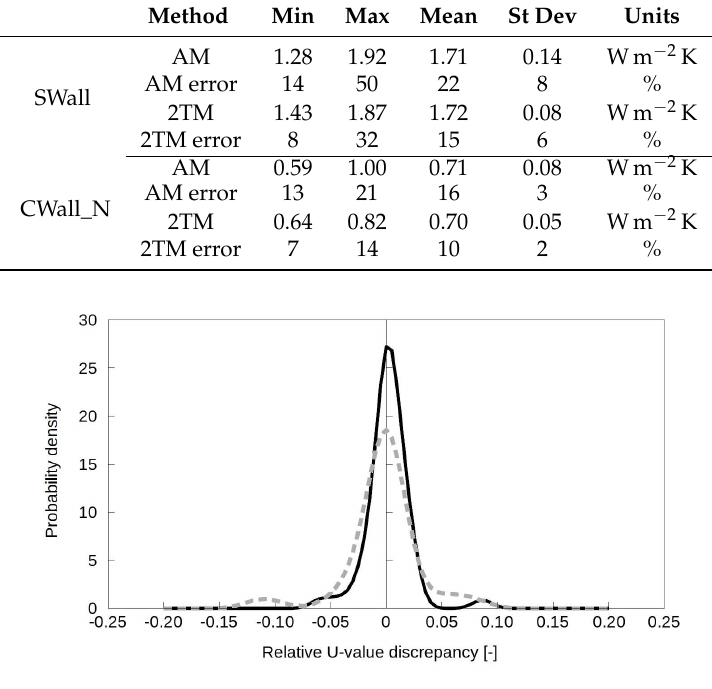
Figure 10. Kernel density estimation of the relative discrepancy between the U -value estimates from the 2TM model and average method, for the SWall (solid line) and the CWall_N (dashed